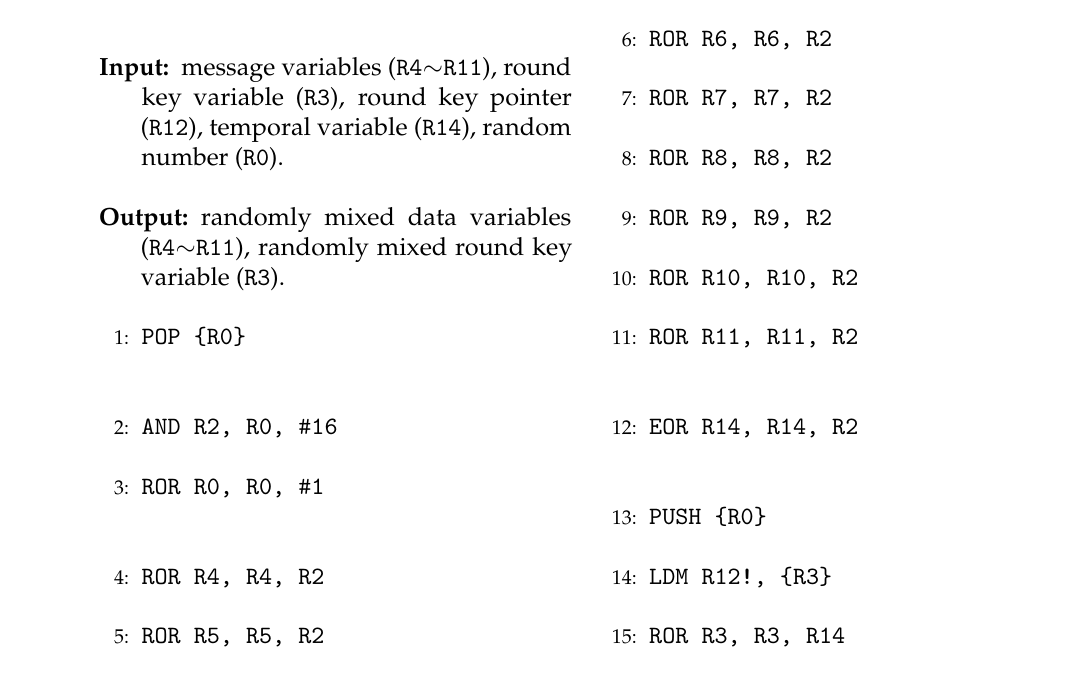
Algorithm 1 Message and Round Key Shuffling for 4-Way Fault Resistance